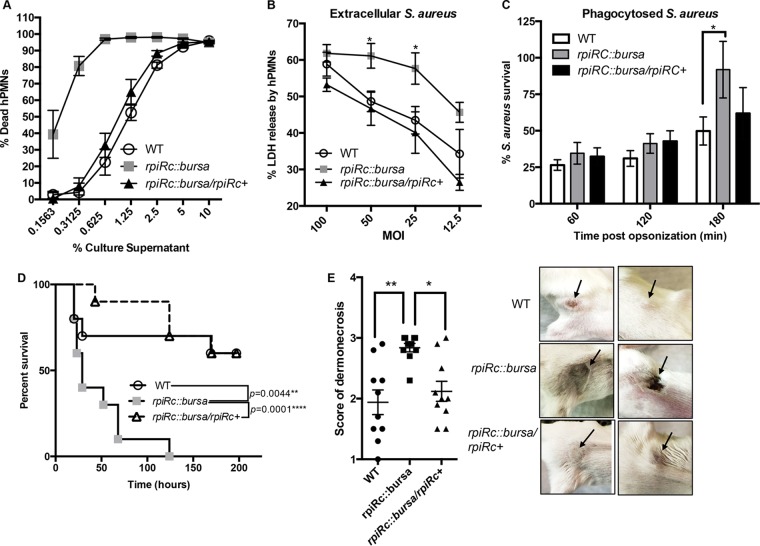
Inactivation of rpiRc enhances the virulence of USA300 LAC. (A) Intoxication of hPMNs (from six donors ± the standard of the mean) with a 2-fold titration of USA300 culture filtrates. Cell death was measured with CellTiter metabolic dye. (B) Infection of hPMNs (from three donors ± the standard of the mean) with the isogenic USA300 strains indicated under nonphagocytosing conditions. Cell death was measured as percent lactate dehydrogenase (LDH) release from lysed hPMNs. Statistical analyses were performed by ANOVA with Dunnett’s multiple comparison test. The asterisk indicates a P value of <0.05 for wild-type (WT) versus rpiRc::bursa bacteria and for rpiRc::bursa versus rpiRc::bursa/rpiRc+ bacteria. (C) Growth rebound of the opsonized USA300 isogenic strains indicated during infection of hPMNs (from three donors ± the standard of the mean) at an MOI of 10 under phagocytosing conditions. Percent survival is the CFU count enumerated at the different time points relative to the start of infection. Statistical analyses were performed by ANOVA with Dunnett’s multiple comparison test. (D) Kaplan-Meier curve showing the percent survival of mice (10/group) infected retro-orbitally with ~5 × 107 CFU of the isogenic strains indicated. Statistically significant differences between curves were determined by log rank (Mantel-Cox) test, and P values are shown. The results were corrected for multiple comparisons by using the Bonferroni-corrected threshold (assumed a statistical significance of 0.05 divided by two comparisons; 0.025). (E) Scores of murine skin lesions and dermonecrosis (five mice per group with two abscesses each) 48 h after intradermal infection with ~1 × 106 CFU of the strains indicated. Each symbol is the average score per site of infection. Statistical analyses were performed with the Kruskal-Wallis test. *, P < 0.05; **, P < 0.005. Representative pictures of skin lesions at 48 h postinfection are shown on the right.